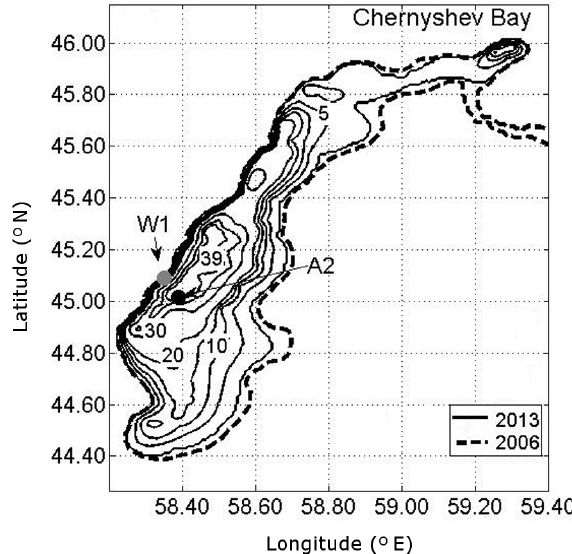
Figure 1. Shoreline of the South Aral Sea in 2006 and 2013 and bathymetric levels in 2013. Locations of the measurement stations (station W1 in 2013 and station A2 in 2006) are